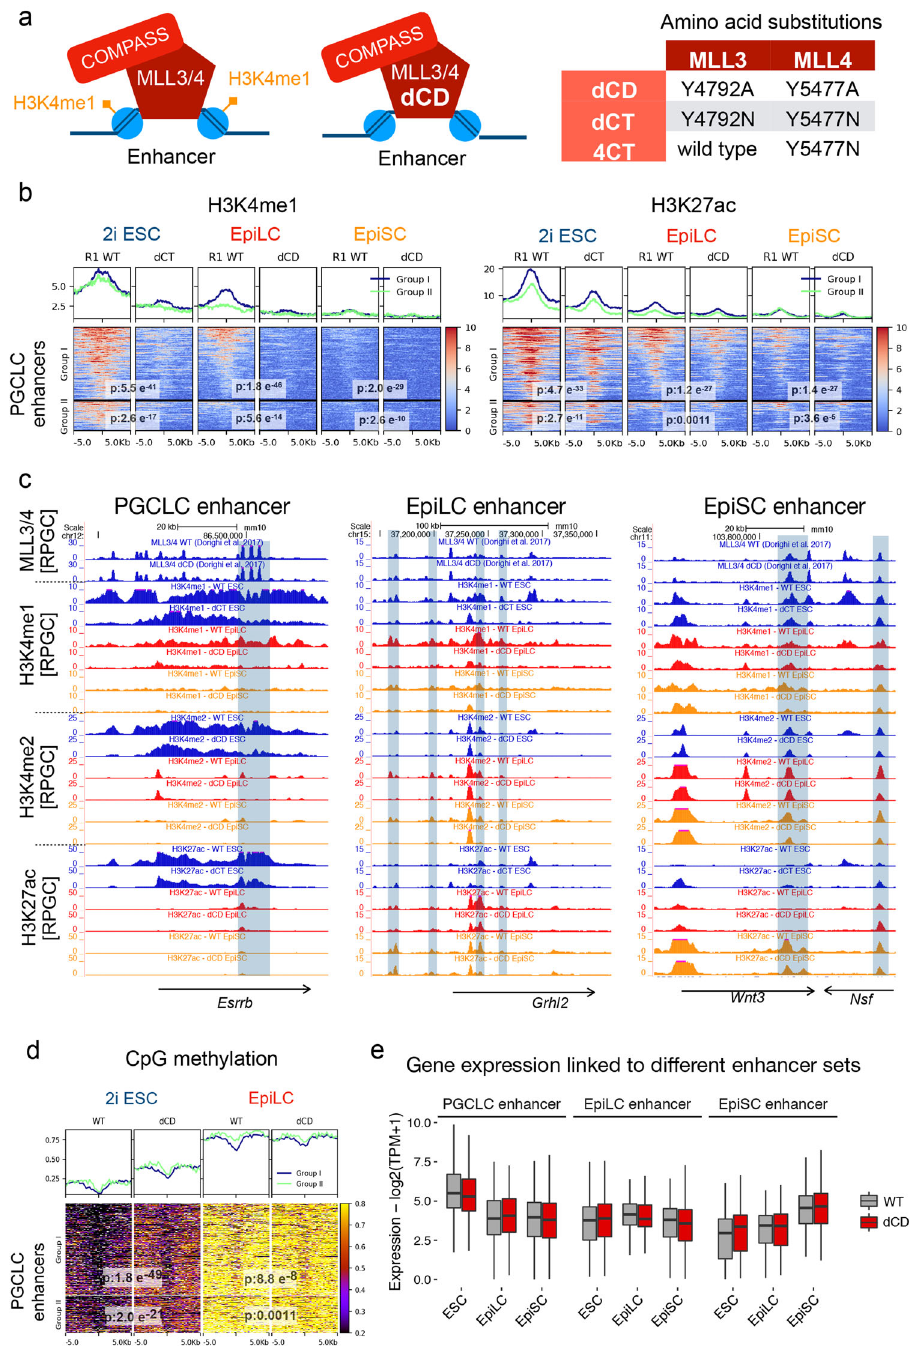
Fig. 5 H3K4me1 is dispensable for enhancer-dependent gene expression in in vitro pluripotent cells. a dCD cells express catalytic mutant MLL3 and MLL4 proteins without histone methyltransferase activity but capable of binding to their target sites and interacting with other proteins as part of the COMPASS complex. The different Mll3/4 catalytic mutants used in this study are shown to the right. b H3K4me1 and H3K27ac levels for the Group I and II PGCLC enhancers in R1 WT and MLL3/4 catalytic mutant ESC lines as well as upon their differentiation into d2 EpiLC and EpiSC. P -values were calculated using paired two-sided Wilcoxon tests. The H3K4me1 ChIP-seq data shown for WT d2 EpiLC and EpiSC are the same ones used in Fig. 3c as a third replicate. Scales: RPGC. c H3K4me1, H3K4me2, and H3K27ac pro fi les in both WT and MLL3/4 catalytic mutant cells (ESC, EpiLC, and EpiSC) around representative PGCLC ( Esrrb) , EpiLC ( Grhl2 ), and EpiSC ( Wnt3 ) genes and their associated enhancers. d Percentage of CpG methylation for the Group I and II PGCLC enhancers in WT and dCD ESC as well as upon their differentiation into d2 EpiLC. P-values were calculated using paired two-sided Wilcoxon tests. The WGBS data in 2i ESC was obtained from Skvortsova et al. 2019 64 . Scale: percentage of methylated CpGs. e Expression (as measured by RNA- seq) of the genes associated with the PGCLC, EpiLC, and EpiSC enhancers in WT (gray) and dCD (red) ESC cells as well as upon their differentiation into EpiLC and EpiSC. The RNA-seq data in ESC was obtained from Dorighi et al. 2017 38 and the experiments in d2 EpiLC and EpiSC were performed in duplicates. The horizontal line in the boxplots indicates the median, the box indicates the fi rst and third quartiles and the whiskers indicate ± 1.5 × interquartile range. TPM transcripts per